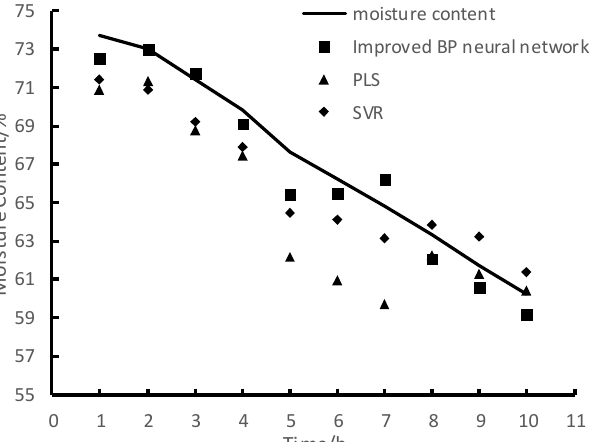
Figure 11. Comparison between the improved BP neural network model and the other models in the validation data. Table 7. Validation metrics for the different models.